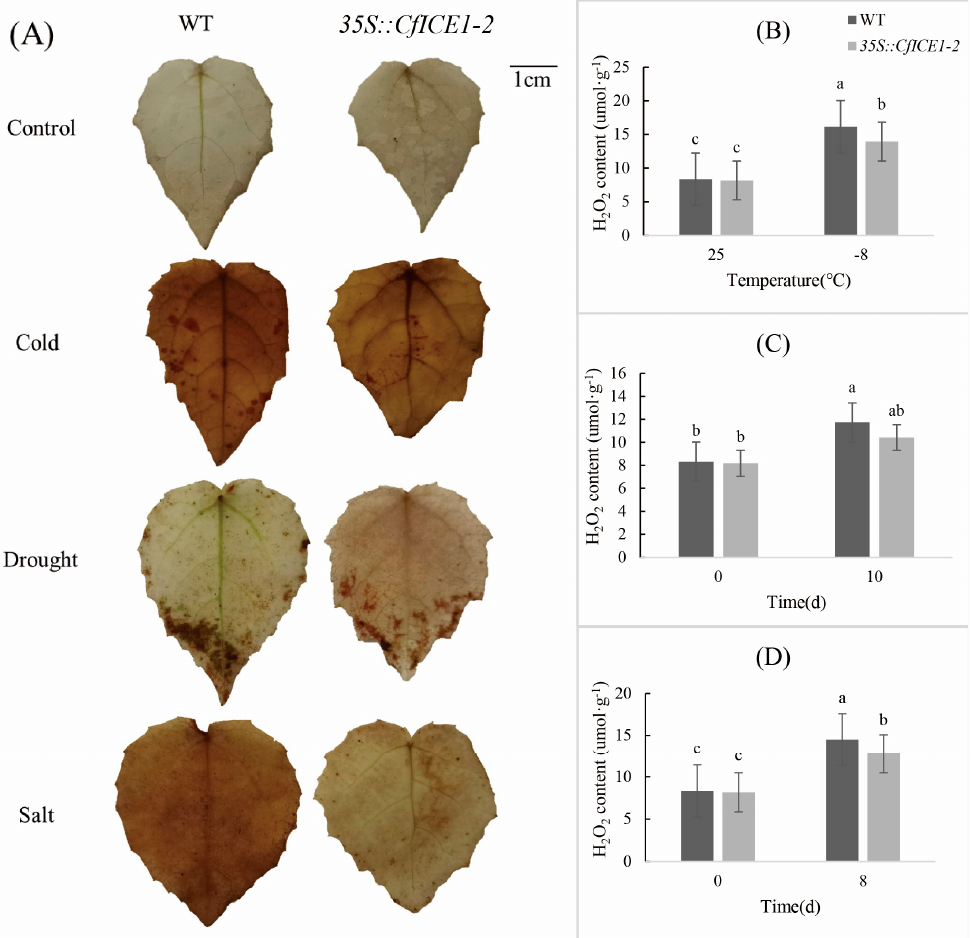
Figure 9. DAB staining and H 2 O 2 content of 35S::CfICE1-2 and WT poplar lines under various stresses. ( A ) DAB staining of 35S::CfICE1-2 and WT poplar lines under cold, drought and salt stress. ( B ) H 2 O 2 content of 35S::CfICE1-2 and WT poplar lines under cold stress. ( C ) H 2 O 2 content of 35S::CfICE1-2 and WT poplar lines under drought stress. ( D ) H 2 O 2 content of 35S::CfICE1-2